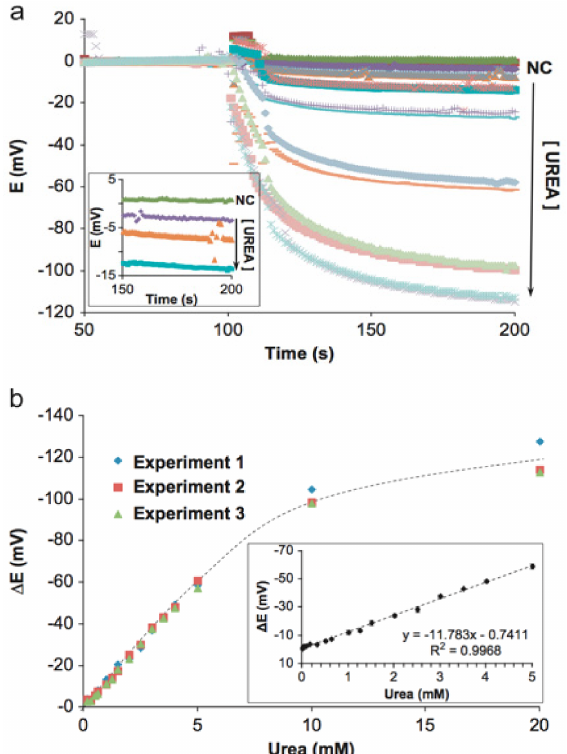
Figure 19. ( a ) Response with Different concentrations of urea (up to down 0.3, 0.6, 1.25, 2.5, 5, 10 and 20 mM). Inset showed the zoom-in part of the first three concentration gradient and negative control comparison. ( b ) Three parallel experiments of urea real sample detection. Inset showed the linear regression of urea with voltage under 5 mM. Reprinted with permission from reference